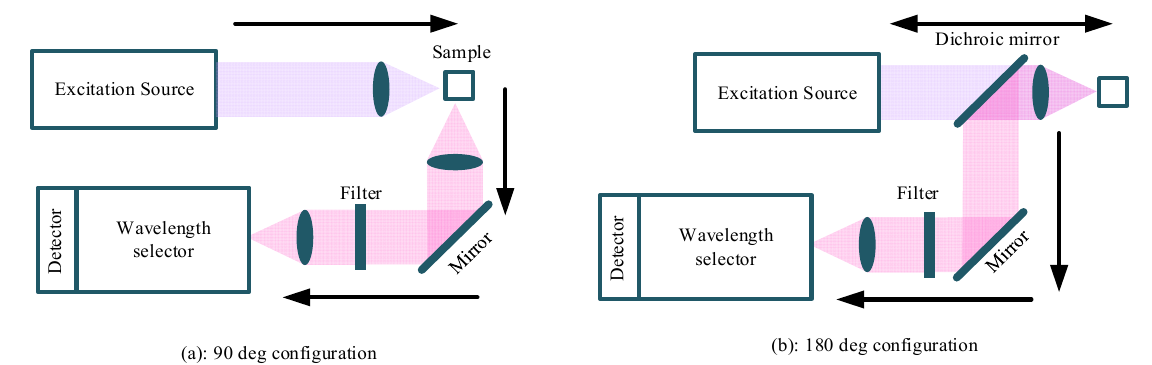
Figure 2. Raman system with: ( a ) 90° and ( b ) 180°